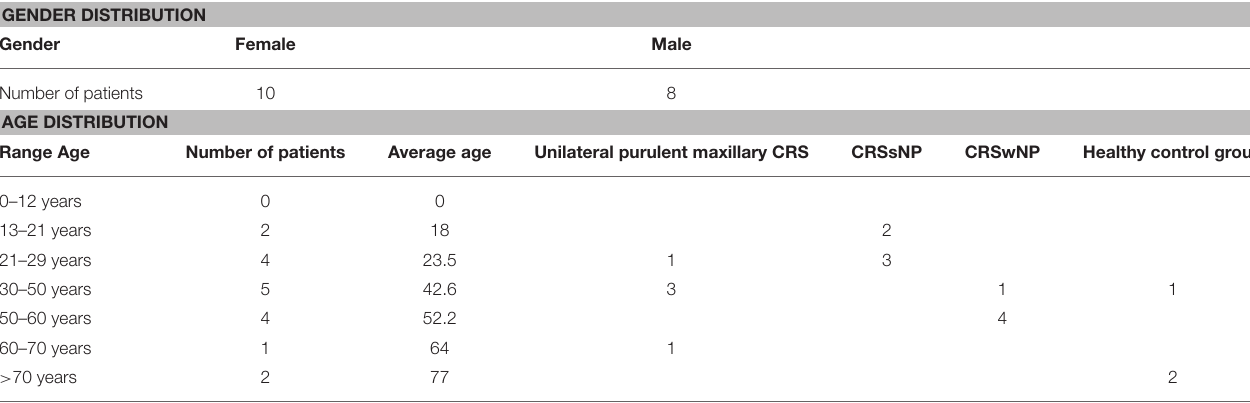
TABLE 1 | Distribution of gender, age and patient type of the study population. GENDER DISTRIBUTION Gender